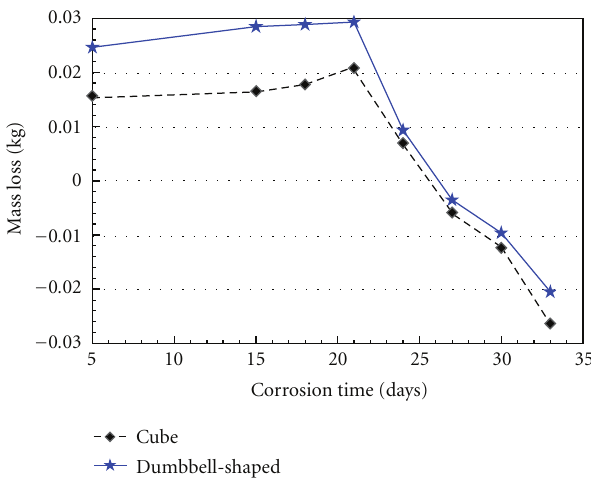
Figure 7: Relation between mass loss and corrosion